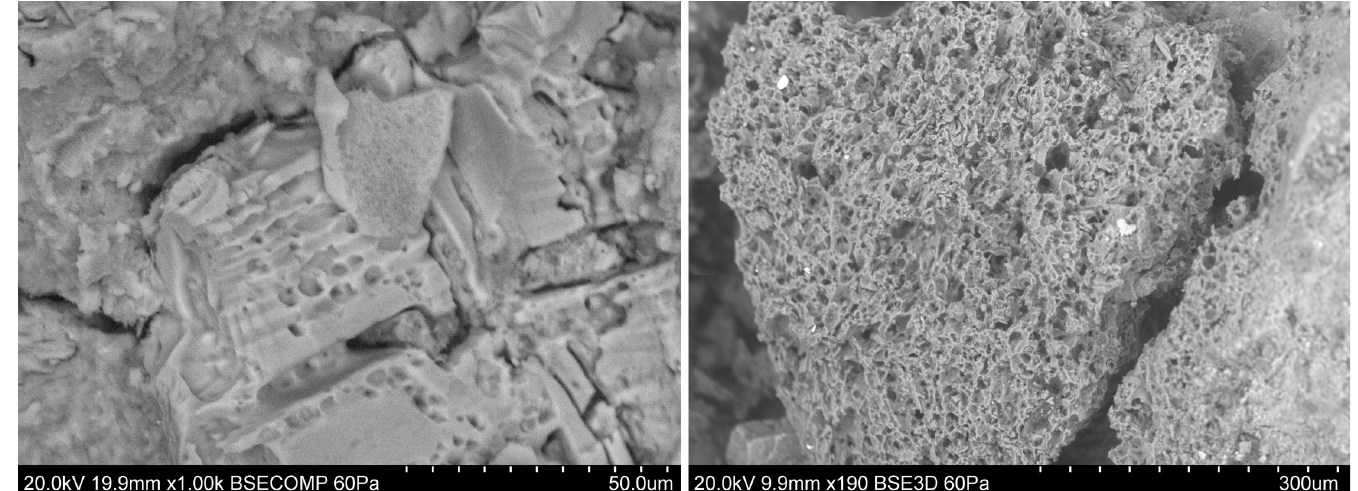
Fig 7. Volcanic inclusions in the fresh fracture of IN04. A. Volcanic glass. B. Pumice found on the fresh face of fragment IN04.